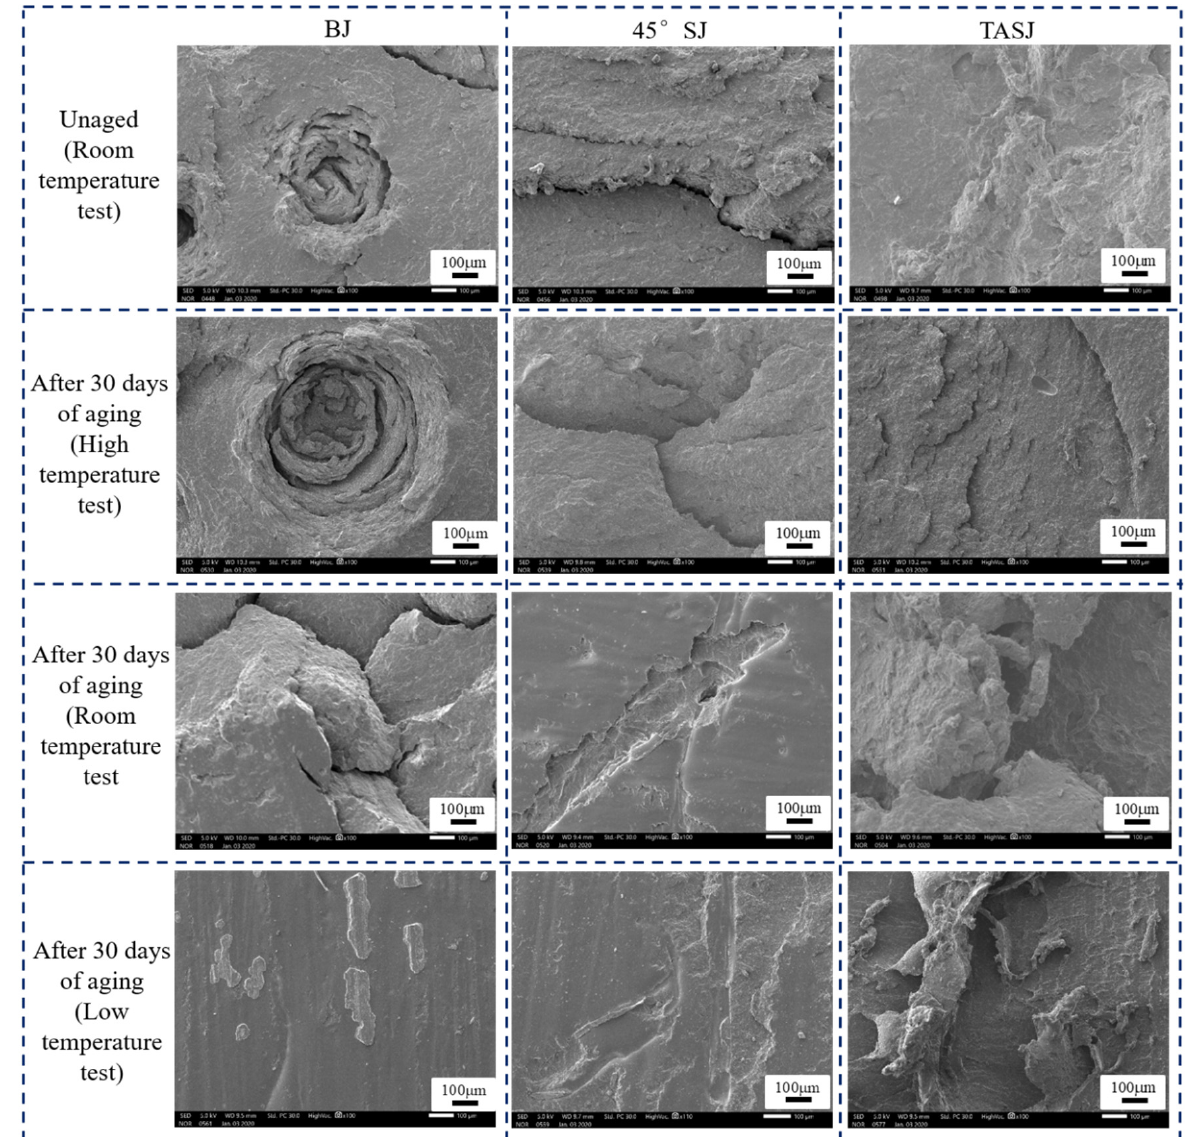
Figure 15. Effect of service temperature on failure section of aged BJs, 45° SJs, and TASJs by SEM (100×).